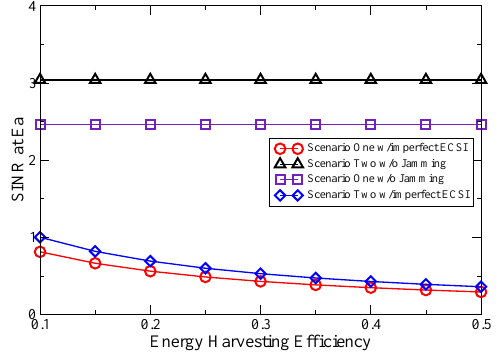
Figure 5. SINR at Ea vs. energy harvesting